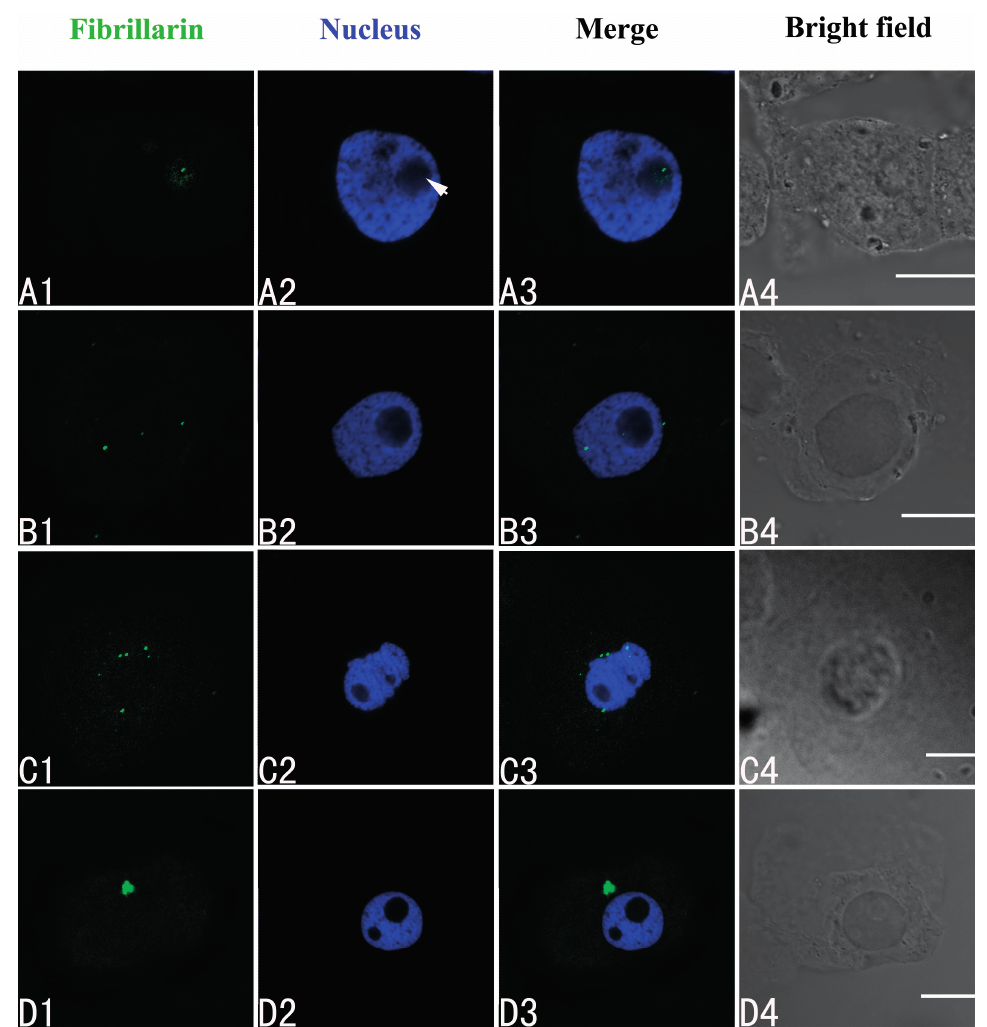
Figure 6. Simultaneous detection of fibrillarin after incubation with primary anti-fibrillarin antibody and secondary antibody conjugated with FITC (green), and of DNA after incubation with DAPI (blue) in the same single optical section using confocal microscopy. ( A1 , B1 , C1 , D1 ) Fibrillarin detection; ( A2 , B2 , C2 , D2 ) DNA detection; ( A3 , B3 , C3 , D3 ) Merged image of “fibrillarin detection” and “DNA detection”; ( A4 , B4 , C4 , D4 ) bright field image. ( A1 – A4 ) Fibrillarin in the nucleolus of control cells; ( B1 – B4 ) Migration of fibrillarin from the nucleolus to the nucleoplasm or the cytoplasm in the cells treated with 100 μ M Pb for 24 h; ( C1 – C4 ) Fibrillarin in the cytoplasm of the treated cells at 48 h, and 72 h ( D1 – D4 ). Scale bars = 10 μ m. Arrowhead shows